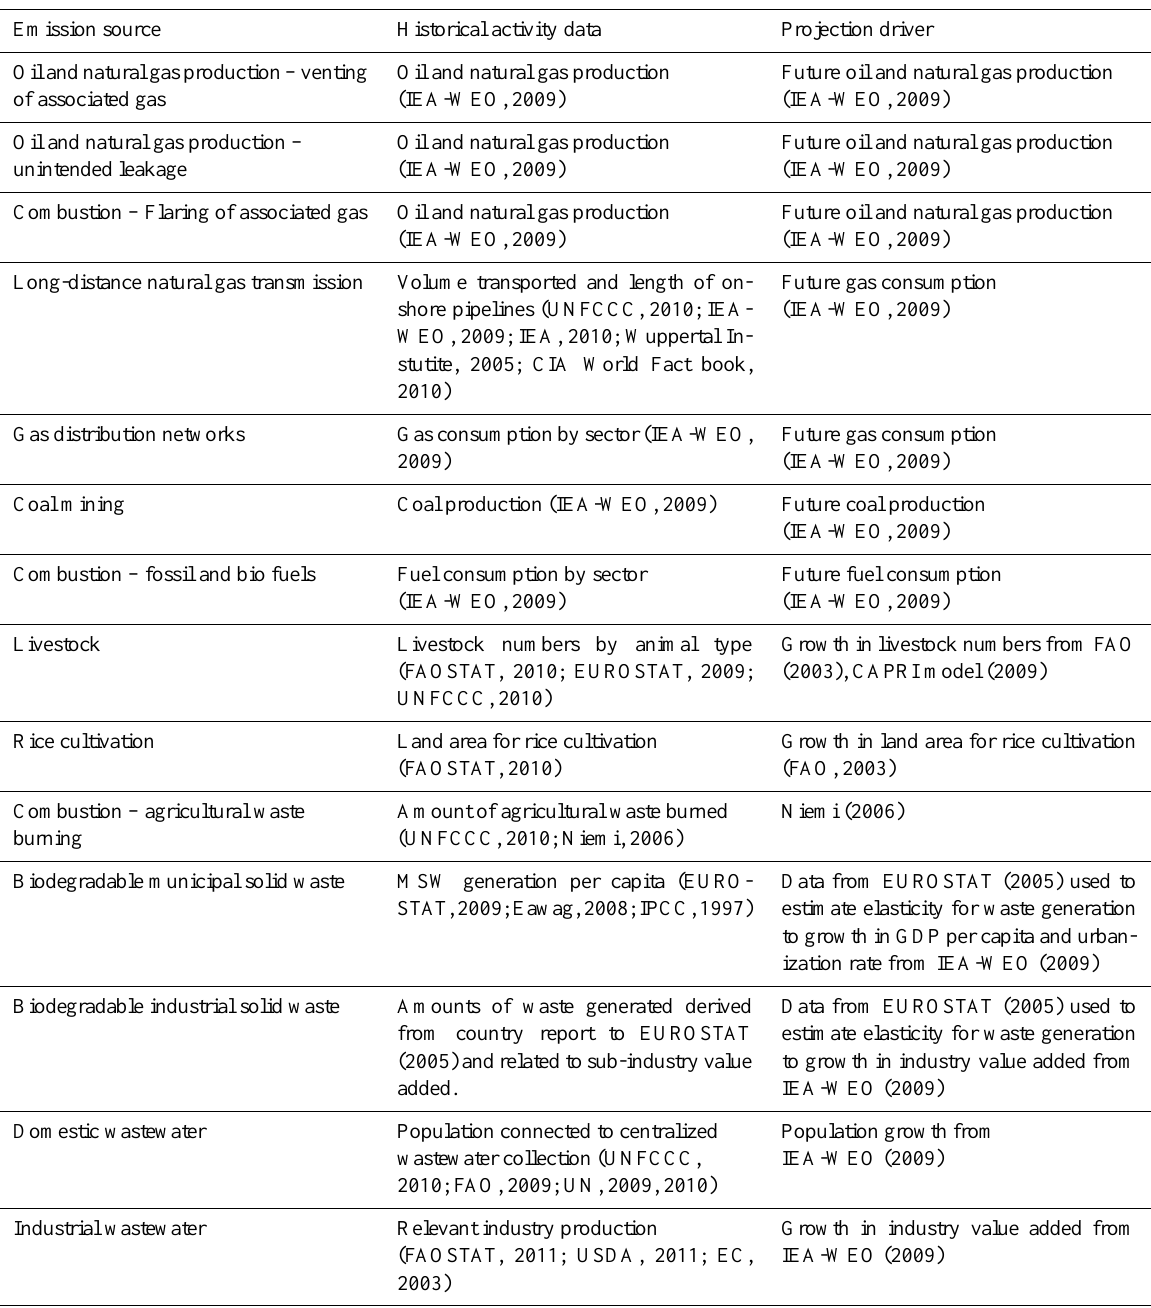
Table 1. GAINS CH 4 emission sources, activity data and